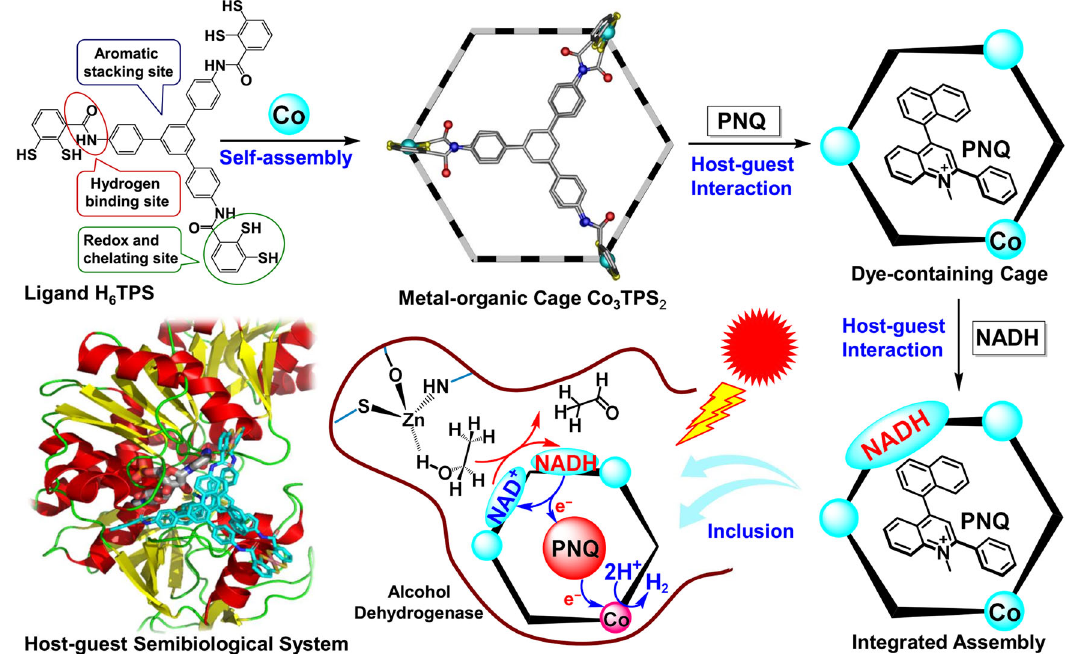
Fig. 1 Schematic of the combination of arti fi cial and natural enzymatic system. Construction of the molecular triangular prism Co 3 TPS 2 , the dye- containing cage, the NADH-dye-cage ternary supramolecular system, and the host – guest semibiological system comprising metal-organic cage Co 3 TPS 2 and natural enzyme ADH via non-covalent interactions, representing the assumed major binding conformation of the cage in the ADH enzymatic pocket from the docking study and the potential communication between arti fi cial proton reduction and enzymatic alcohol dehydrogenation via the NAD + /NADH